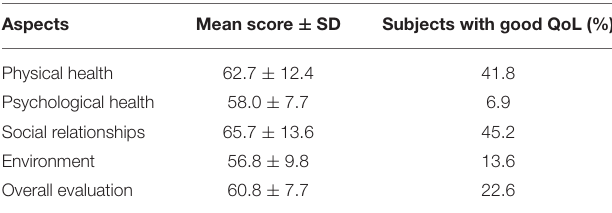
TABLE 1 | Quality of life (QoL) of the research subjects on the WHOQOL-BREF scale ( n =